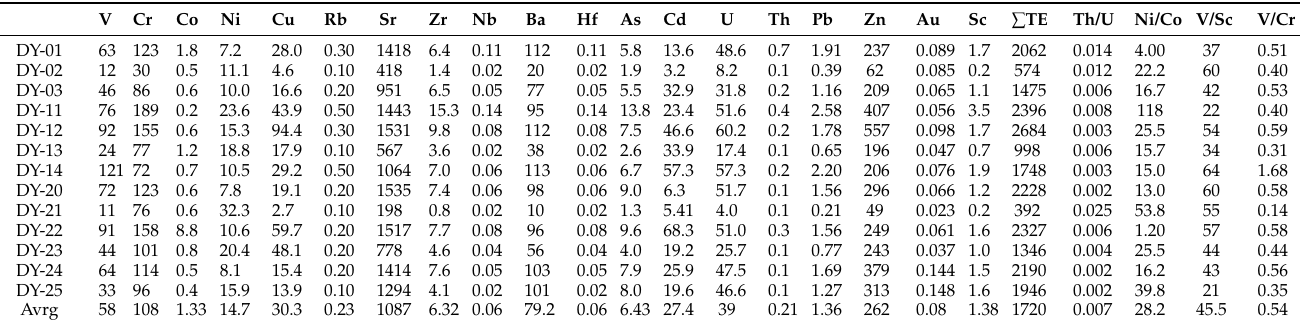
Table 3. Trace element concentrations (ppm) of the phosphate samples.